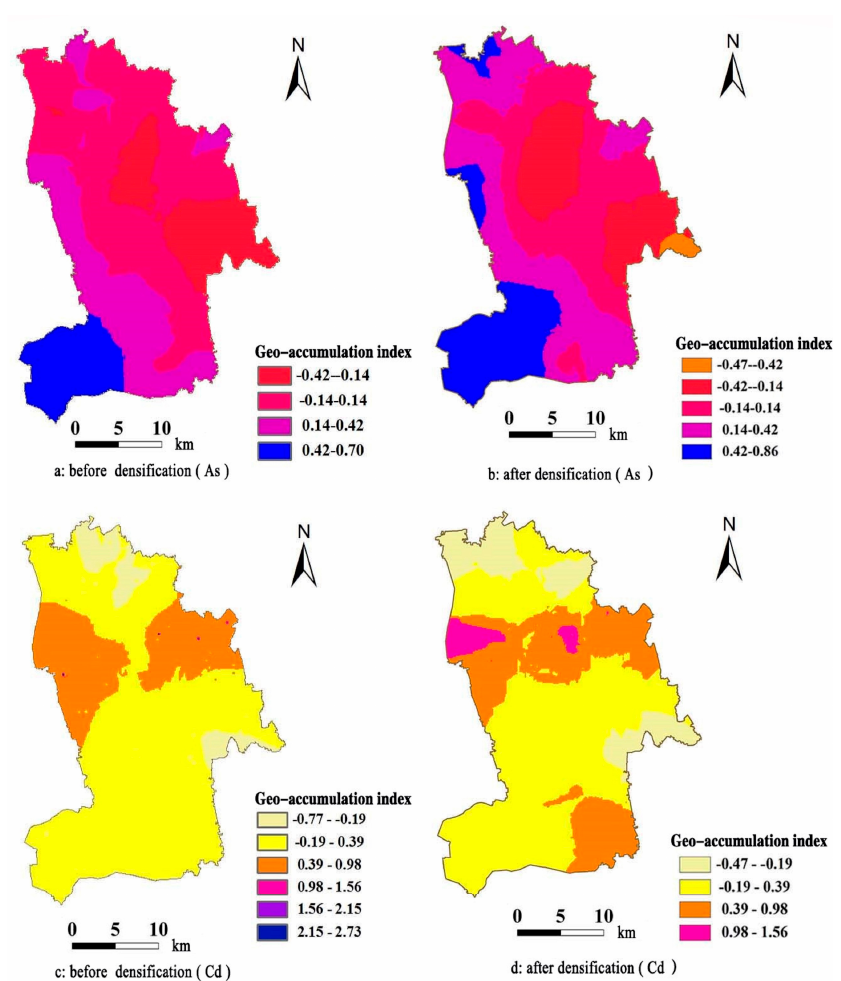
Figure 2. Spatial distribution maps of the geo-accumulation indices of As and Cd before and after densification. The classification of the geo-accumulation index was obtained by using natural break interval approach. ( a ) The geo-accumulation index of As before densification; ( b ) the geo-accumulation index of As after densification; ( c ) the geo-accumulation index of Cd before densification; ( d ) the geo-accumulation index of Cd after densification.